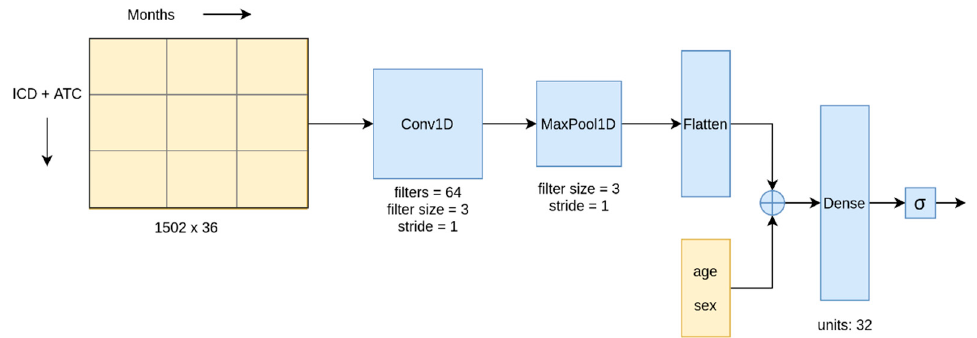
Figure 5. The CNN architecture used in this study.